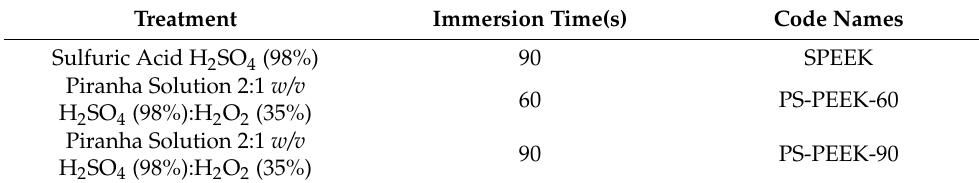
Table 1. Test parameters and sample